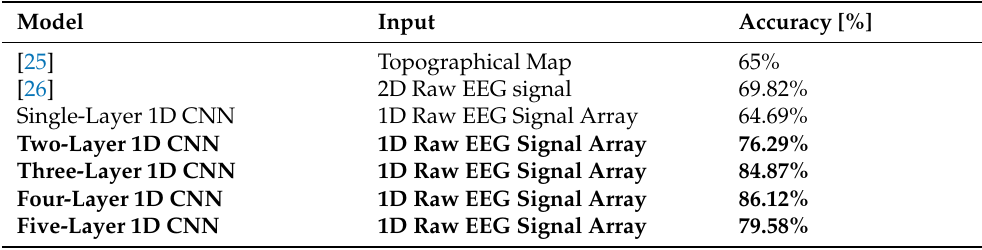
Figure 23. Results of 1D raw EEG signal representation with the 1D CNN models. The pink dashed line indicates results reported in [25]. The purple dashed line indicates results reported in [26]. Table 5. The 1D raw EEG signal array results. Contrary to the previous forms of data representations, models based on the 1D array achieved significant improvements in the classification of MI in comparison with the previous experiments. Although the first 1D CNN model was unable to outperform the studies from the state of the art, the rest of the models returned results with a significant increase in accuracy performance. The best results were obtained through the three- and four-layered models, with an accuracy of 84.87% and 86.12% respectively. Best results that outperformed the state of the art are highlighted in